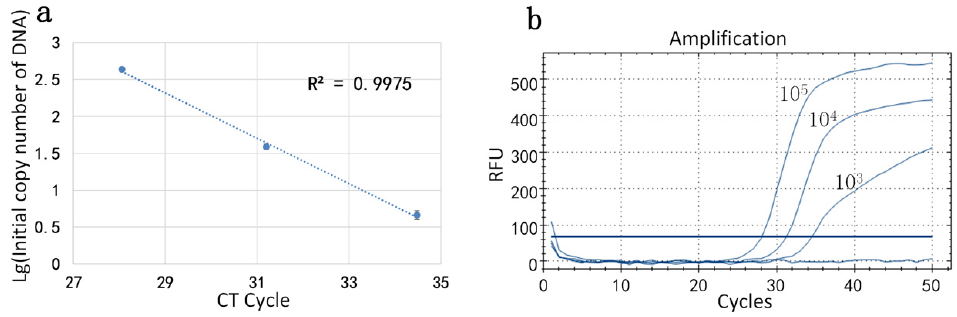
Figure 6. ( a ) Standard curve of reagents measured by our device. ( b ) Amplification curve of the reagents measured by commercial qPCR (BIO-RAD CFX Connect).